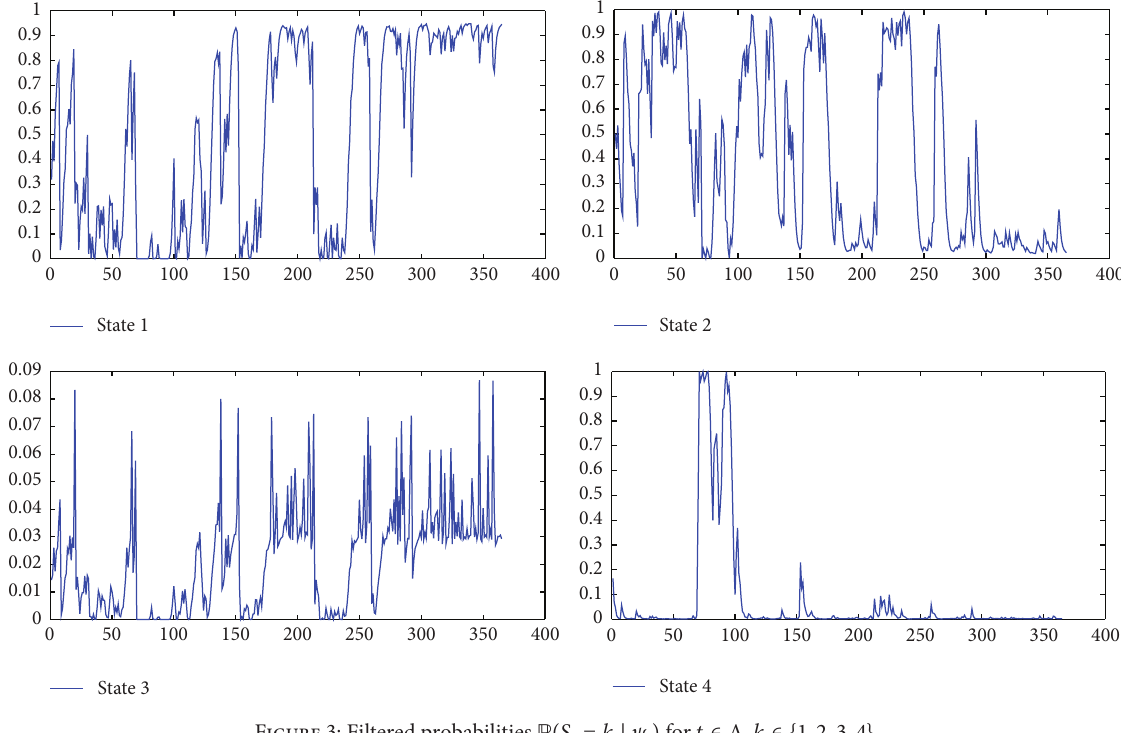
Figure 3: Filtered probabilities P (𝑆 𝑡 = 𝑘 | 𝜓 𝑡 ) for 𝑡 ∈ Λ , 𝑘 ∈ {1,2,3,4} .